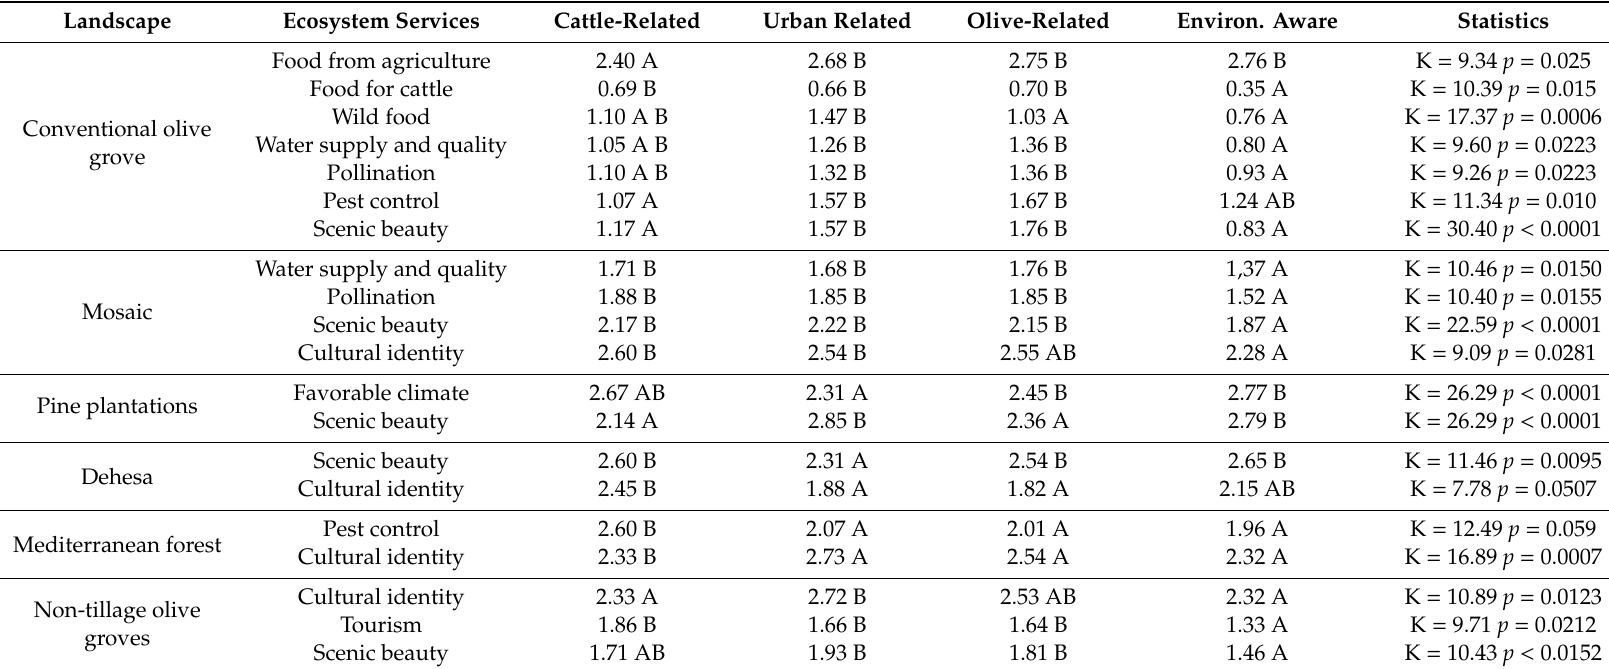
Table 3. Significant results from Kruskal–Wallis analysis among stakeholder clusters for ecosystem services valuation. Only services that showed significant di ff erences among groups ( p -value < 0.05) are included (the complete results of the analysis are provided in Table